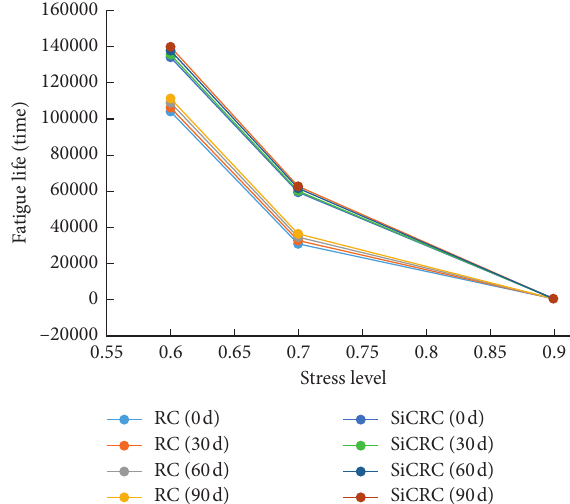
Table 4: Fatigue life ( N ) for SiCRC. Specimen no.